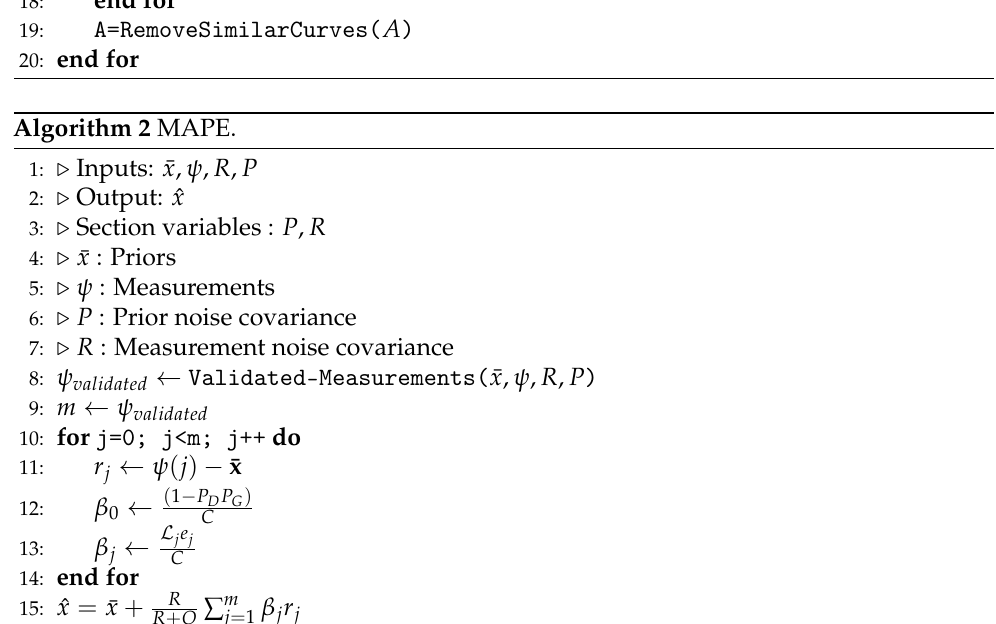
Algorithm 2 combines both the data association and the posteriori PDF to adjust